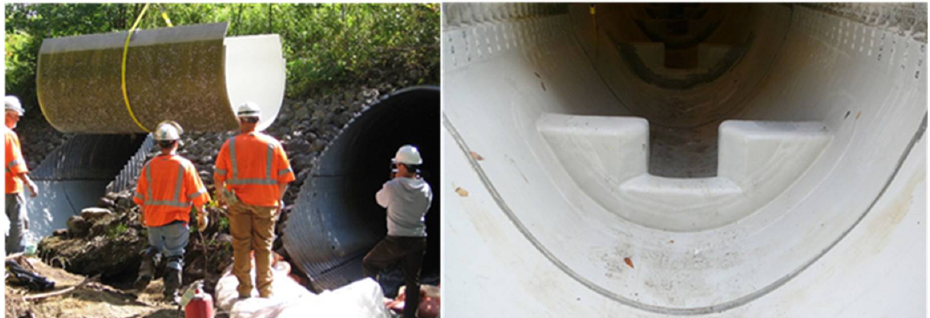
Figure 3. Refurbishment of a corroded steel culvert using partial FRP lining [21].